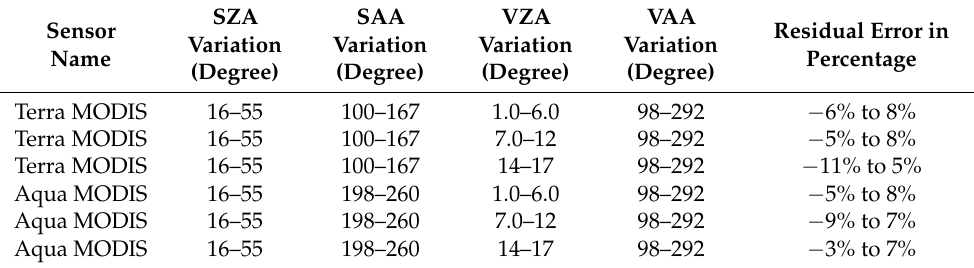
Table 14. Residual Error for three different levels of view geometries found on Aqua and Terra MODIS